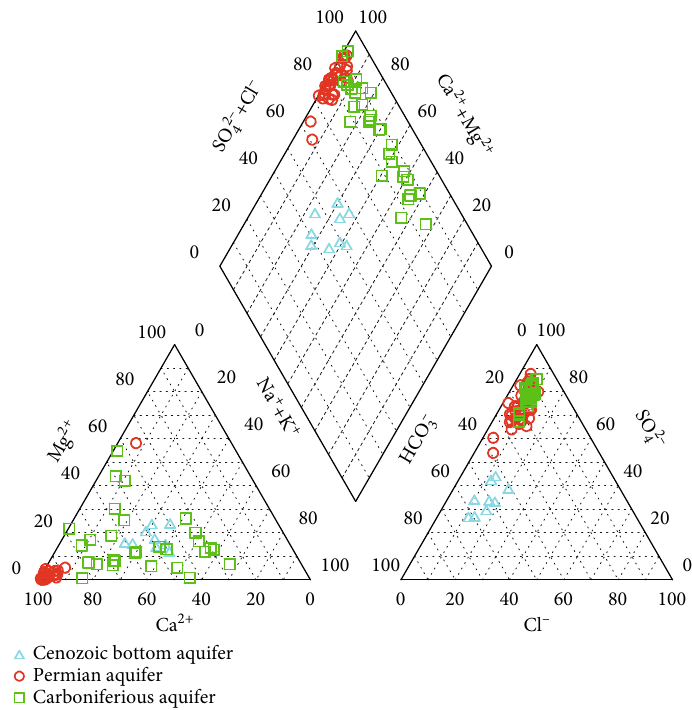
Figure 2: Piper diagram of groundwater samples from the Cenozoic, Permian, and Carboniferous